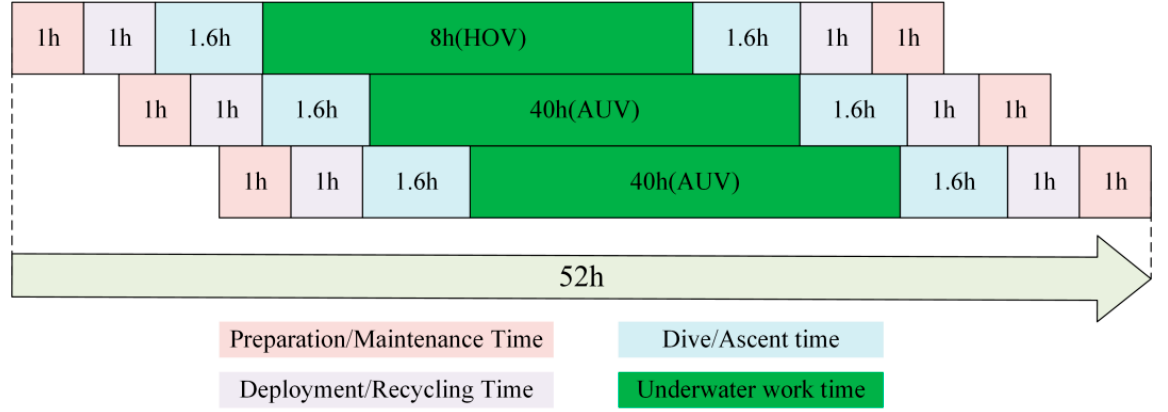
Figure 11. Elapsed time in cooperative operation mode based on the pure research vessel R/V.